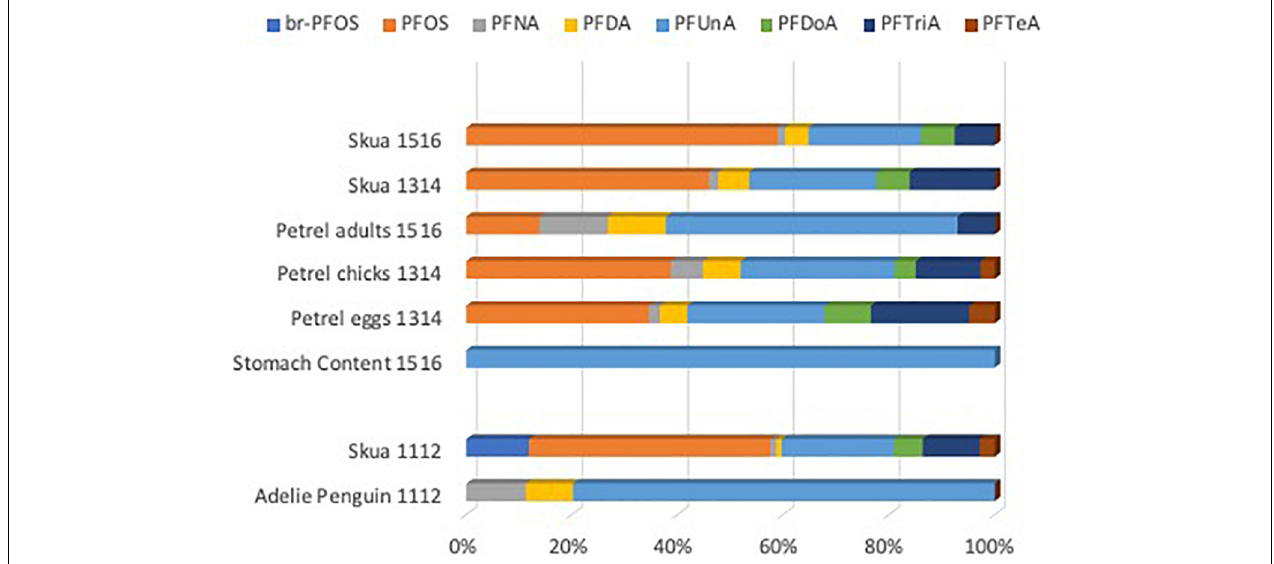
FIGURE 2 | Relative pattern of the per- and polyfluoroalkyl substance (PFAS) compounds (% of summed PFAS) found in more than the four groups of samples at Svarthamaren, Dronning Maud’s Land in 2013/2014 and 2015/2016 and Dumont d’Urville, Adélie Land in 2011/2012 in Antarctica. The patterns show PFAS compounds with two or more detections, representing the mean of values for the respective